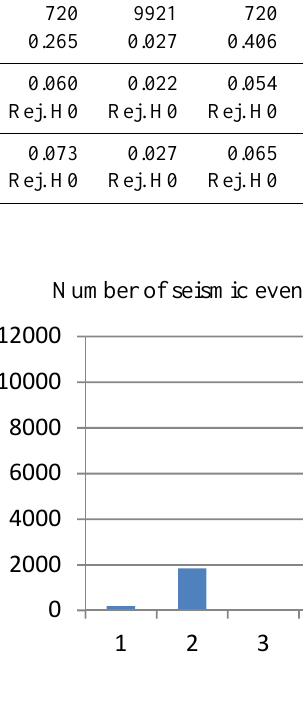
Fig. 10. A plot showing the number of seismic events in each seis- Figure 10. A plot showing the number of seismic events in each seismic zone. 14 mic